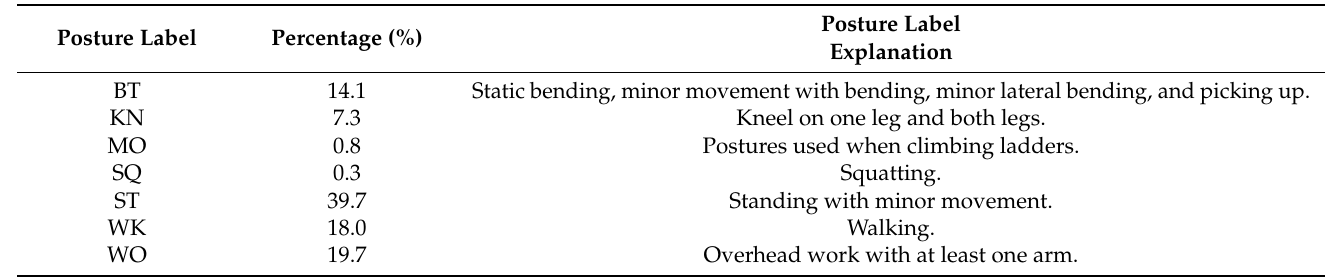
Table 8. Description of collected motion data.